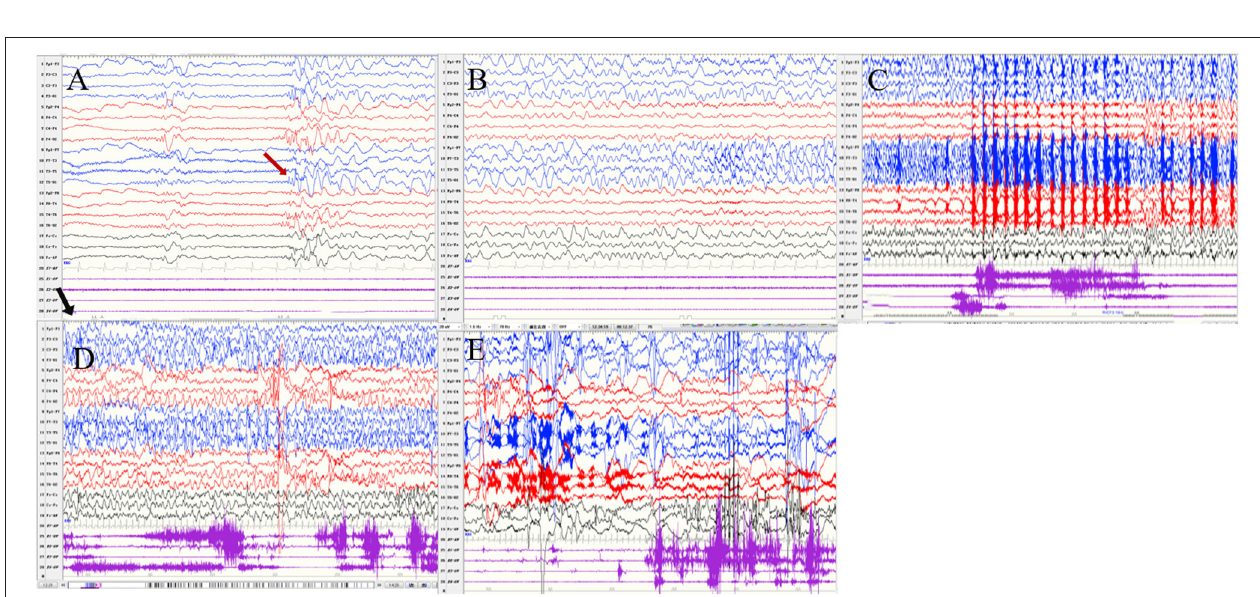
FIGURE 5 | The ictal EEG of patient 4 (A – E) slow waves in the left temporal region → sharp wave rhythm in the left temporal region spreading to the contralateral temporal and frontal regions → irregular spikes mixed slow waves in the left hemisphere (The red arrow represents the origin of the seizure; the black arrow represents the starting point of the IPS.) (EEG, electrocardiogram; IPS, intermittent photic stimulation; X1, left deltoid; X2, right deltoid; X3, left quadriceps; X4, right quadriceps).